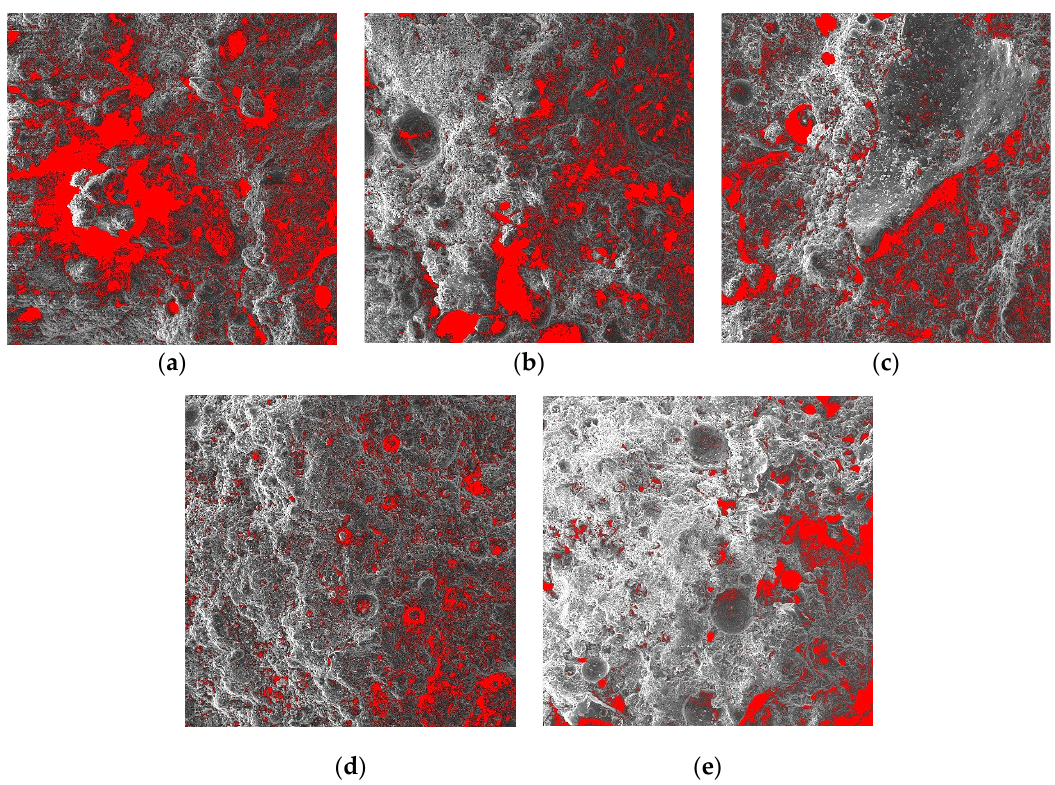
Figure 7. Pore structure analysis at different curing periods: ( a ) 1 d of pore structure analysis, ( b ) 3 d of pore structure analysis, ( c ) 7 d of pore structure analysis, ( d ) 14 d of pore structure analysis, and ( e ) 28 d of pore structure analysis.